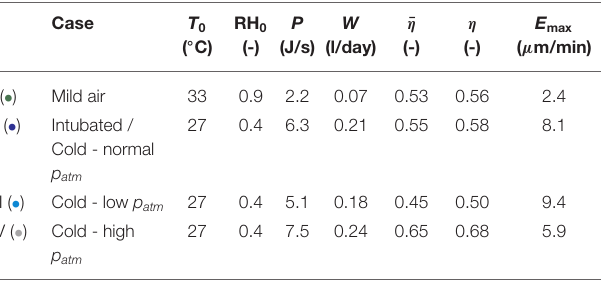
TABLE 3 | Calculation results, breathing by the nose or intubated, in mild or very cold air, at normal, low or high ambient pressure.